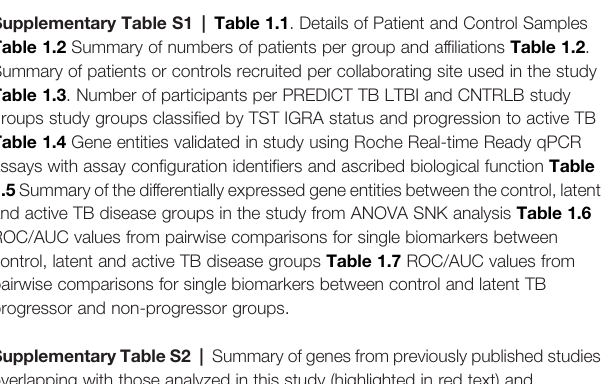
Table 3.6 . ROC/AUC results, plus sensitivity, speci fi city, likelihood ratios and positive and negative predictive values for key combinations of signi fi cant biomarkers across all ATB and LTBI groups compared with controls Table 3.7 . Diagnostic accuracy of biomarker panels assessed using fi xed sensitivities and/or speci fi cities de fi ned by the WHO technology product pro fi les for triage or con fi rmatory tests Table 3.8 . Comparison of performance of biomarker panels (A – F) with regard to control and patient groups and the WHO technology product pro fi les for the minimum and optimal triage and con fi rmatory tests. Supplementary Table S4 | Performance of optimal biomarker panels on other previously published data sets. Supplementary information S1 | Figure 1.1 Distribution of the number of entities differentially regulated between groups from ANOVA, performed across all groups using BH FDR (corrected p value < 0.05) and using the SNK post hoc test. Figure 1.2 . Line graph of CD52 normalized intensity values across all TB disease and control groups. Figure 1.3 . Line graph of GBP1 normalized intensity values across all TB disease and control groups. Figure 1.4 . Line graph of GBP2 normalized intensity values across all TB disease and control groups. Figure 1.5 . Line graph of GBP5 normalized intensity values across all TB disease and control groups. Figure 1.6 . Line graph of HLA-B normalized intensity values across all TB disease and control groups. Figure 1.7 . Line graph of IFIT3 normalized intensity values across all TB disease and control groups. Figure 1.8 . Line graph of IFITM3 normalized intensity values across all TB disease and control groups. Figure 1.9 . Line graph of IRF1 normalized intensity values across all TB disease and control groups. Figure 1.10 . Line graph of LOC400759 normalized intensity values across all TB dis-ease and control groups. Figure 1.11 . Line graph of NCF1C normalized intensity values across all TB disease and control groups. Figure 1.12 . Line graph of PF4V1 normalized intensity values across all TB disease and control groups. Figure 1.13 . Line graph of S100A11 normalized intensity values across all TB disease and control groups. Figure 1.14 . Line graph of SAMD9L normalized intensity values across all TB disease and control groups. Figure 1.15 . Line graph of STAT1 normalized intensity values across all TB disease and control groups. Figure 1.16 . Line graph of TAF10 normalized intensity values across all TB disease and control groups. Figure 1.17 . Line graph of TAPBP normalized intensity values across all TB disease and control groups. Figure 1.18 . Line graph of TRIM25 normalized intensity values across all TB disease and control groups. Supplementary Information S2 | Figure 2.1 . Cluster analysis on group averaged data for all statistically signi fi cant entities from ANOVA (p < 0.05) (A) low TB incidence region UK control group (CNTRLA) (B) low TB incidence region UK control from the PREDICT TB study group (CNTRLB) (C) low TB incidence region UKLatentTBfromthePREDICTTBstudygroup(LTBI) (D) highTBincidenceregion extra-pulmonary TB group (IEPTB) (E) low TB incidence region UK pulmonary TB group (UKPTB) (F) high TB incidence region pulmonary TB group (IPTB). Entities which show expression differences between the LTBI_NPR and LTBI_PR groups are boxed in red, with the boxed region showing the highest expression compared to that in the relative other group. Supplementary Information S3 | Figure 3.1 Heatmap of the 17-plex entities showing individual expression pro fi les across the disease and control groups. The topthreerankedpatientsamples2439,1053and1864fromthecumulativescoring analysis using the 7-plex signature are highlighted with red arrows. Supplementary Information S4 | Description of the group association and biological function of the 17 statistically signi fi cant biomarkers from Supplementary Information S4